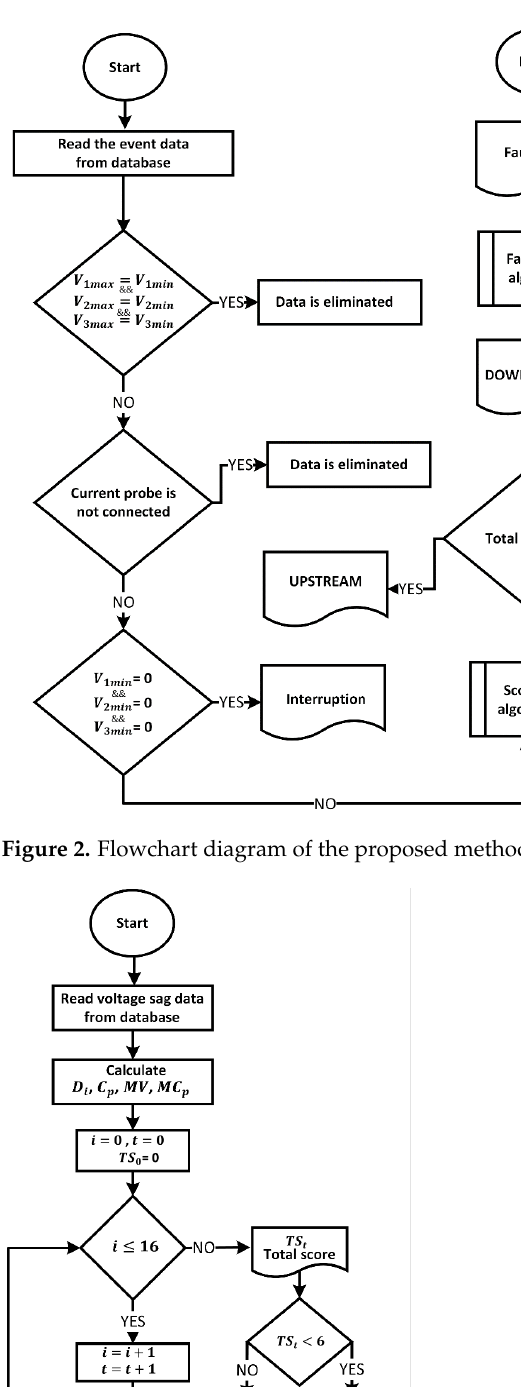
Figure 4. Flowchart diagram of fault type algorithm.